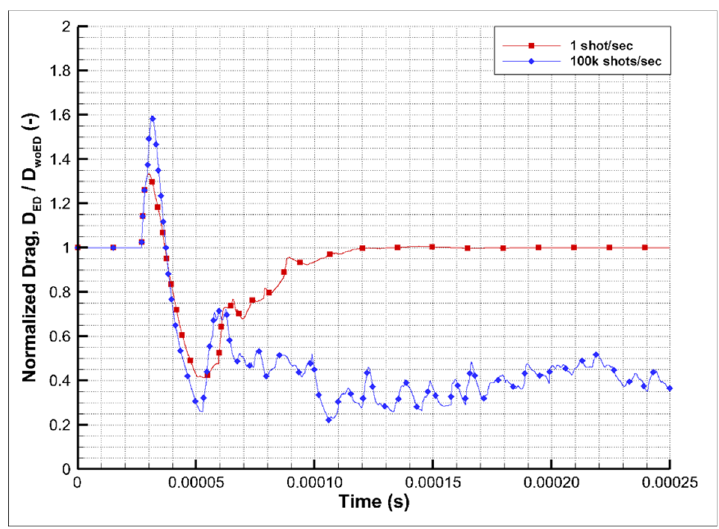
Figure 4. Normalized drag vs. time for deposition frequency of 1 Hz (red) and 10 kHz (blue).